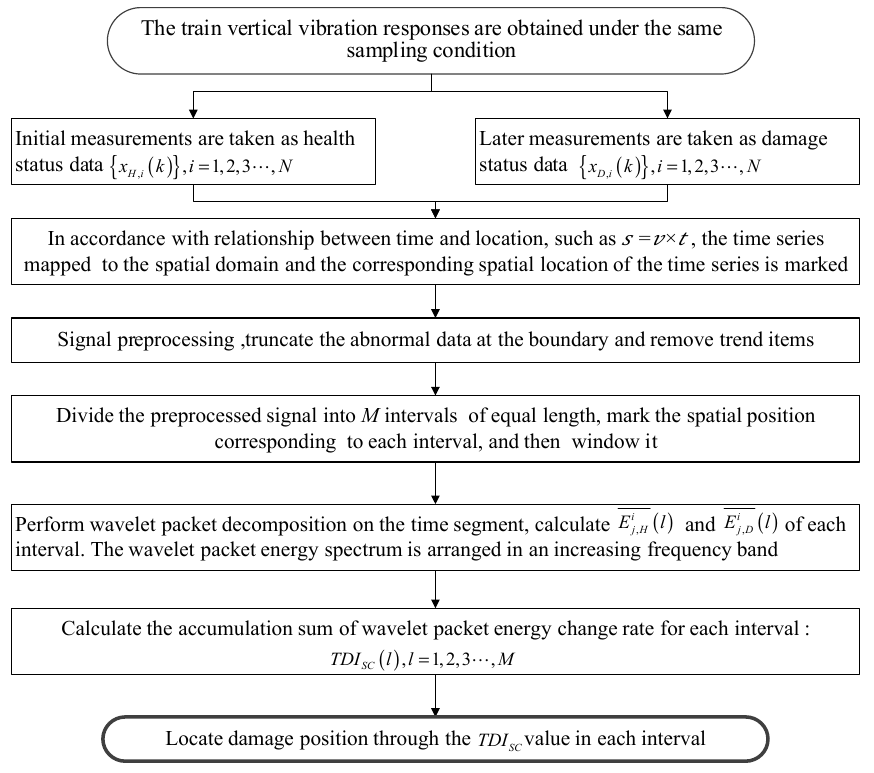
Figure 3. The damage index algorithm flow chart by accumulation sum of wavelet packet energy change.